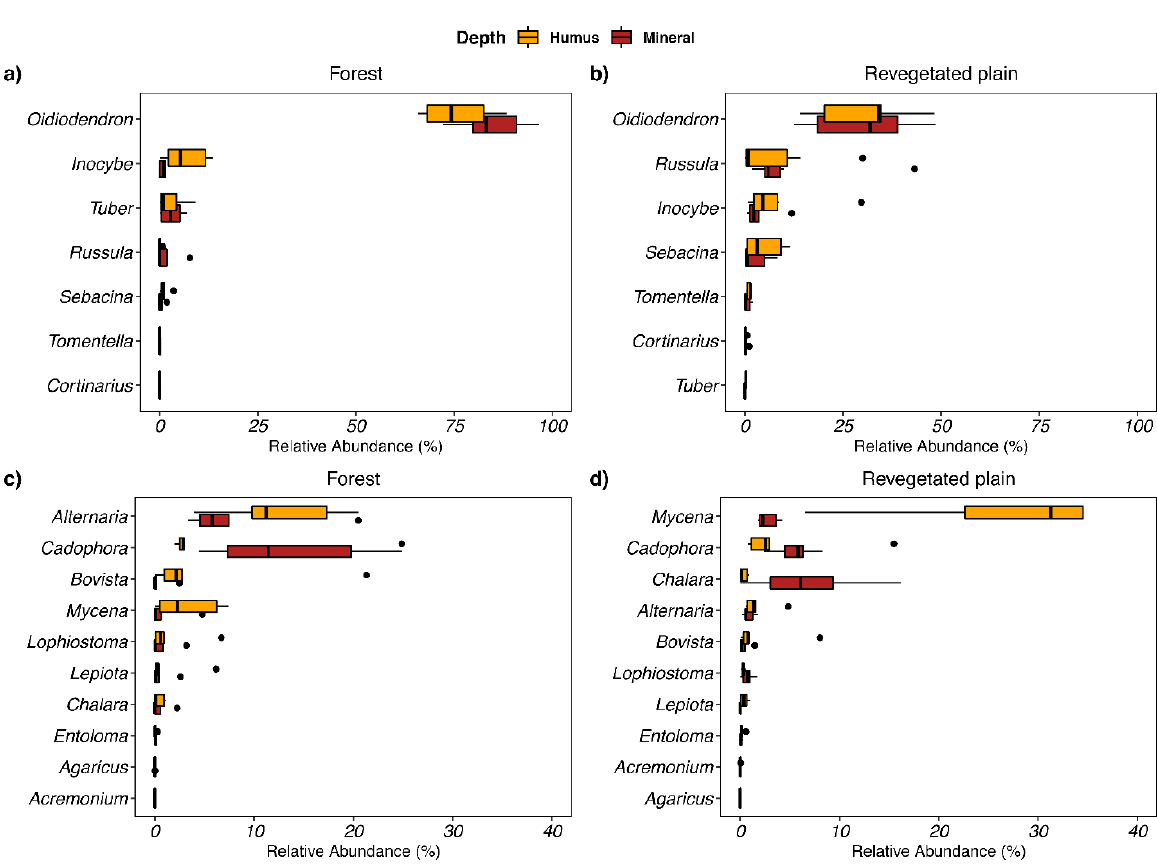
Figure 3. Boxplots of biomass of mycorrhizal and saprotrophic fungi (ppb) per two different soil layers (H = humus, and Mn = mineral layer) in two different areas in the mine experiment (forest = Q. ilex stand, and Plain = shrubs/grassland area) in Mediterranean Spain.